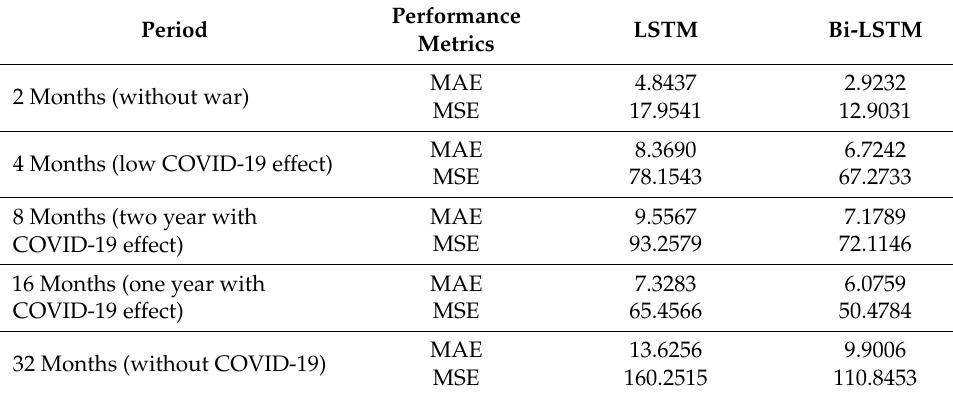
Table 4. Performance results using deep